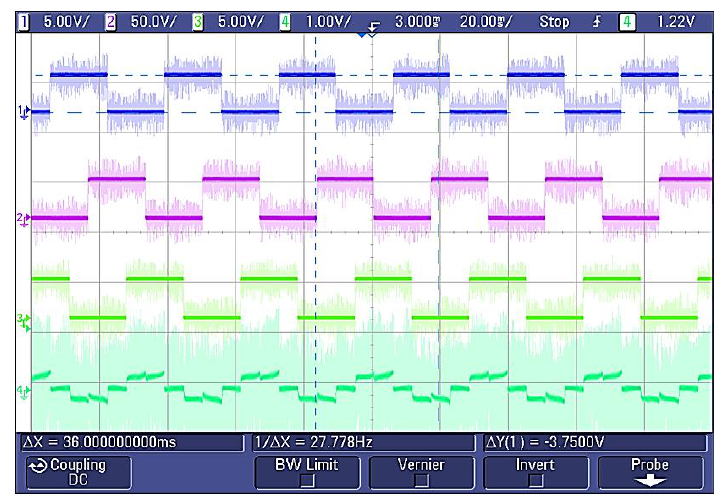
Figure 18. Hall sensor signals and stator current waveform of the BLDC motor.